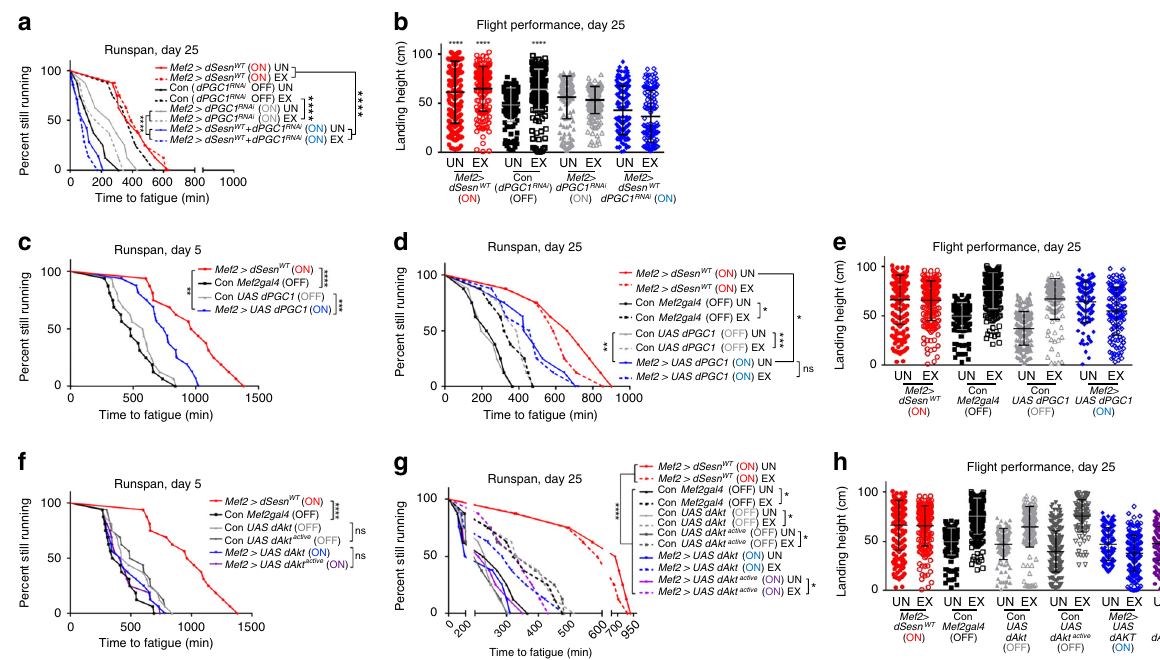
Fig. 7 PGC1 is critical for endurance-extending effects of exercise and Sestrin. Flies expressing indicated transgenic components were analyzed by runspan ( a , c , d , f , g ) and fl ight performance ( b , e , h ) assays at indicated days. See Fig. 2 for details of how individual strains were prepared. Mef2 > dSesn WT (ON) and Con Mef2gal4 (OFF) data from the same cohort are shown as a reference. Biologically independent animal groups: n = 8, 8, 8, 8, 8, 8, 7, 7 ( a , upper to lower; groups of 20 fl ies), n = 16 ( c , f ; groups o f 20 fl ies), n = 8 ( d , g ; groups of 20 fl ies). Biologically independent animals: n = 227, 172, 164, 209, 227, 235, 138, 126 ( b , left to right), n = 211, 202, 207, 196, 182, 128, 104, 133 ( e , left to right), n = 211, 202, 207, 196, 138, 168, 223, 115, 146, 221, 168, 205 ( h , left to right). Error bars, s.d. * P < 0.05, ** P < 0.01, *** P < 0.001, **** P < 0.0001 or ns, non-signi fi cant from a log-rank test (runspan) or two-tailed student ’ s t test (all other